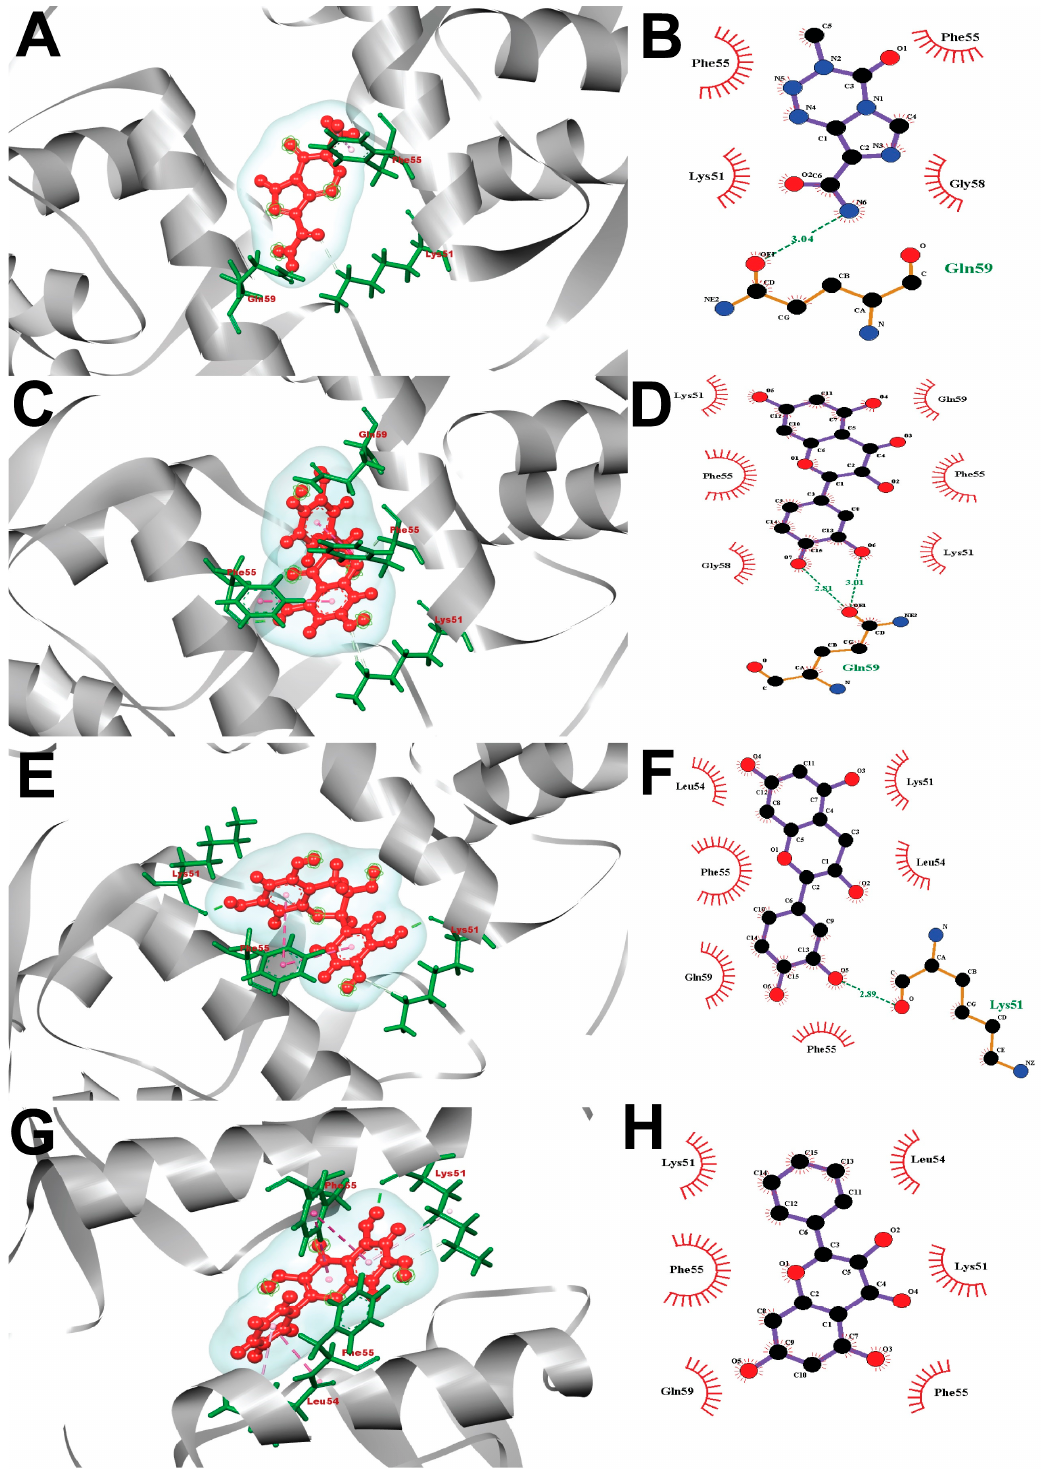
Figure 10. The interaction of all the ligand compounds with MDM2 protein was exhibited. The left-sided figures illustrate the 3D complex, while the right-sided figures illustrate the 2D complex of the protein–ligand interaction. Here, ( A , B ) represented the 3D and 2D interaction of control drug Temozolomide (PubChem CID-5394) with MDM2 protein, whereas ( C , D )-compound Taxifolin (Pub- Chem CID-439533), ( E , F )-compound (-)-Epicatechin (PubChem CID-72276), and ( G , H )-compound Galangin (PubChem CID-5281616) were depicted comparatively in interaction with the MDM2 protein